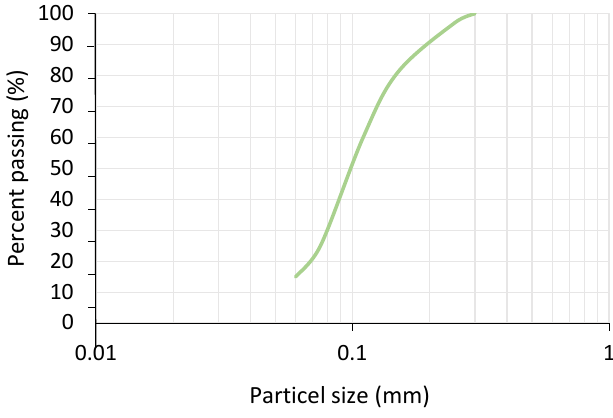
Fig. 1: Particle size distribution of the testing soil